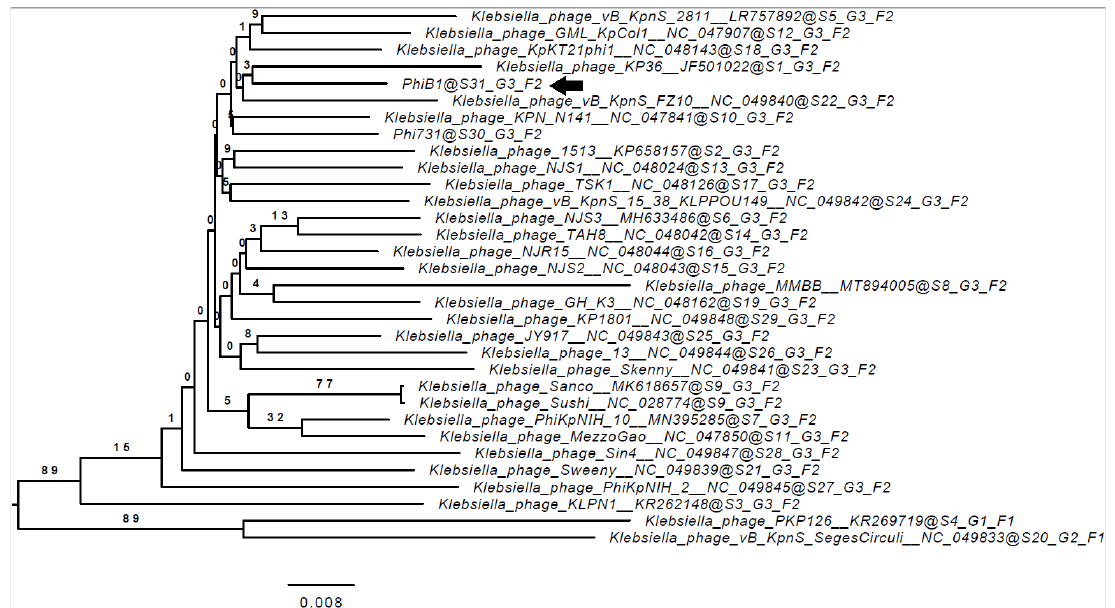
Figure 4. Whole genome-based phylogenetic relations of phage B1. Genome–BLAST distance phylogeny (GBDP) trees were inferred using the formula D4 and yielded average support of 9%. The numbers above branches are GBDP pseudo-bootstrap support values from 100 replications. The branch lengths of the resulting VICTOR trees are scaled in terms of the respective distance formula used. The OPTSIL clustering (results indicated after the @ mark) yielded 31 species clusters (S), 3 clusters at the genus level (G), and 2 at the family level (F). Accession numbers are also indicated next to the phage names. Klebsiella phage B1 is marked with a black arrow ( ).